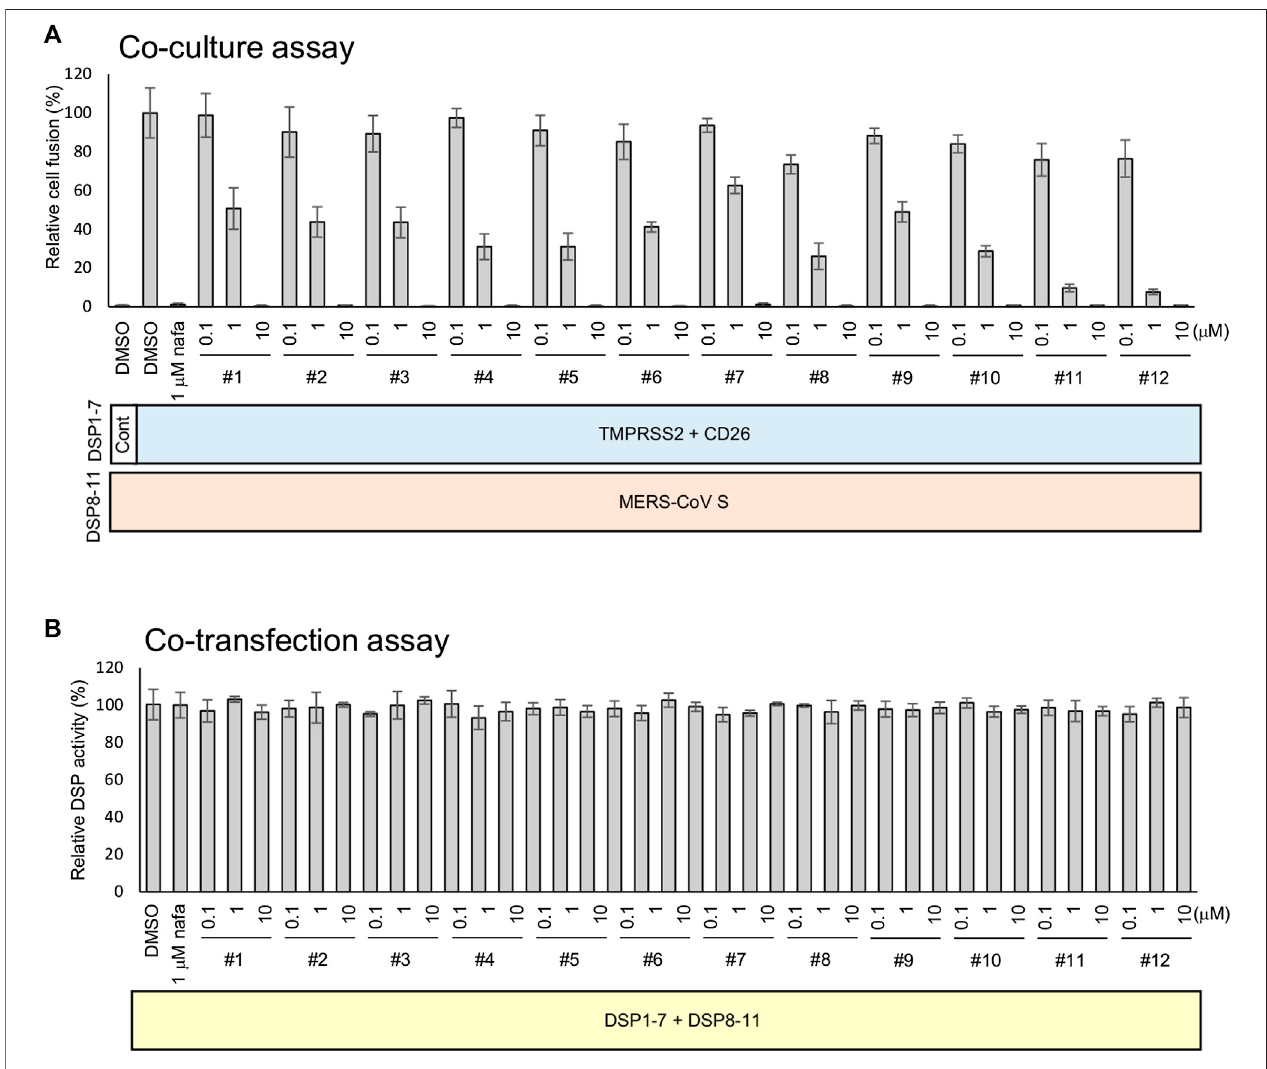
FIGURE 3 | The effect of peptides on the TMPRSS2-dependent cell-cell fusion assay of MERS-CoV. (A) The effect of each peptide on coculture fusion using DSP as a reporter. Peptides were tested at different concentrations, and the proteins in addition to the reporters (DSPs) transduced into the effector and target cells are indicated below the graph. Nafamostat was used as an inhibitor of the TMPRSS2 pathway. The relative cell fusion was represented as the DSP value (RL activity measured in RLU) normalized to that of the control assay with DMSO alone. (B) The effect of each peptide on RL measurement. Each peptide was added to cells co-expressing DSP1-7 and DSP8-11 to evaluate its direct inhibitory effects on RL. The relative DSP signal is indicated on the vertical axis by representing the control value with DMSO alone to 100%.